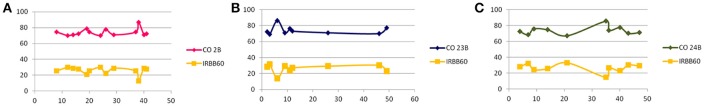
Graphical representation of background analysis. Y- axis represents the percentage of recurrent parent genome recovery using polymorphic SSR markers distributed all over the 12 chromosomes (RPGSSR) in BC1F1 generation (A) CO 2B × IRBB60, (B) CO 23B × IRBB60, and (C) CO 24B × IRBB60. While, X- axis indicates the number of agro-morphologically selected plants from foreground analysis subjected to RPGSSR analysis carrying xa5, xa13, and Xa21 gene combination.